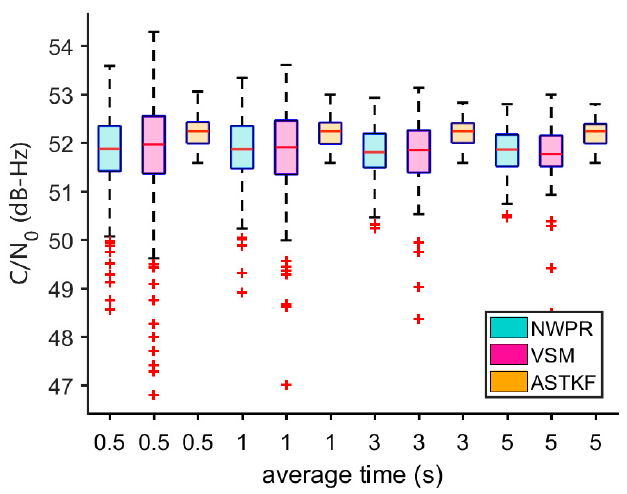
Figure 12. Satellite 10 C/N 0 estimation box plot comparison.